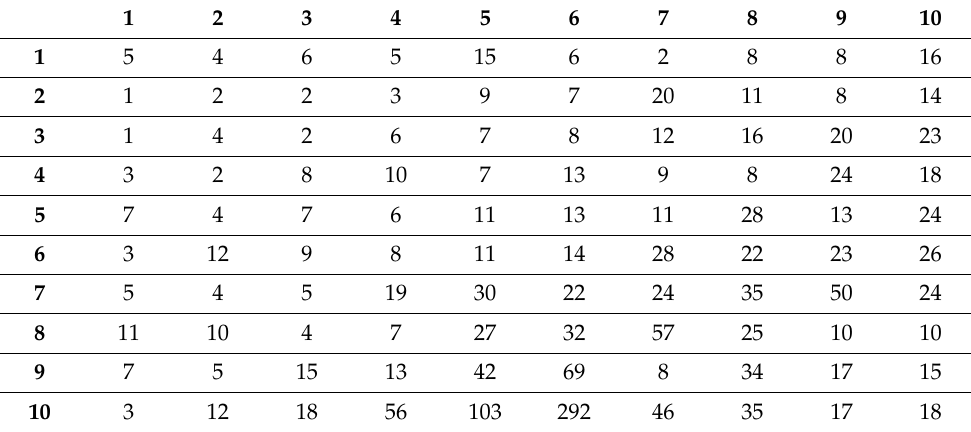
Table 4. Number of companies in individual clusters for the year 2015.